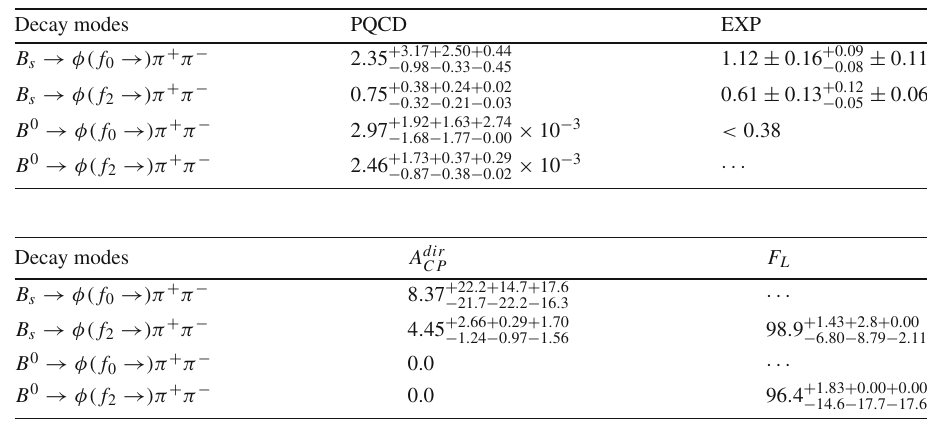
branching ratios (in 10 − 6 ) of B d , s → φ( f 0 / f 2 → )π + π − decays in PQCD approach together with experimental data from Refs. [22,102]